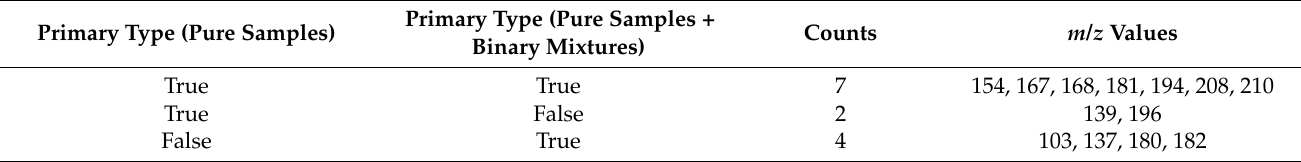
Table 7. Spectral features (ions) specific to classification problems using RUV-corrected data. Primary Type (Pure